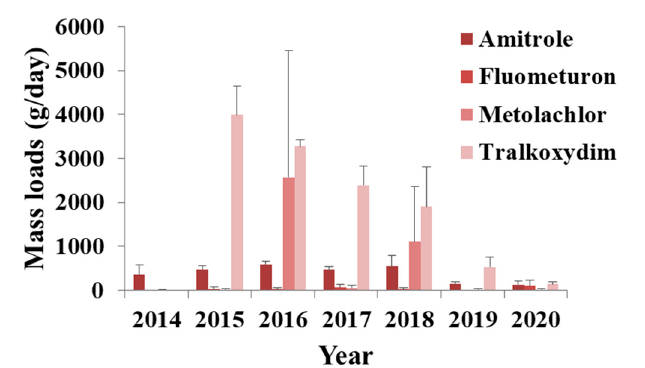
Figure 3. Mass loads of the most frequently detected herbicides (amitrole, fluometuron, metolachlor and tralkoxydim) in influent wastewater collected in Athens.